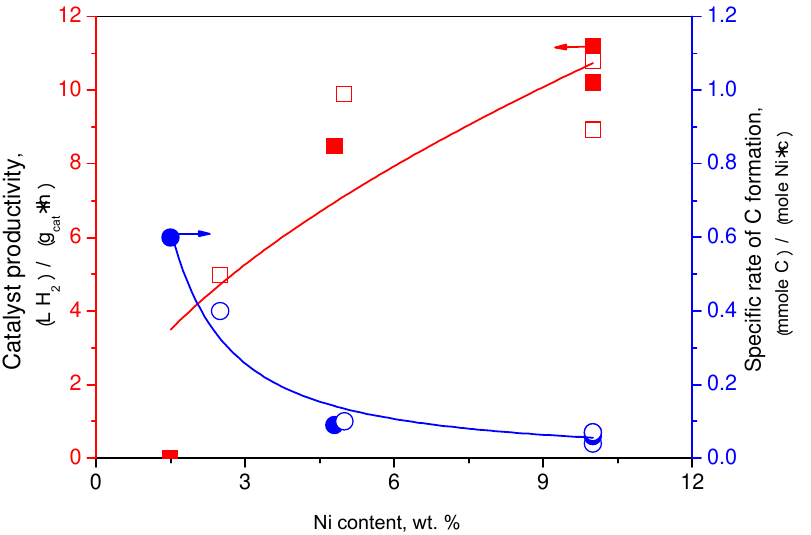
Figure 11. The effect of Ni content on the Ce 1 − x Ni x O 2 − x /Al 2 O 3 catalysts’ productivity (red) and the specific rate of coke formation (blue). Open symbols—CI-series; filled symbols—SG-series.